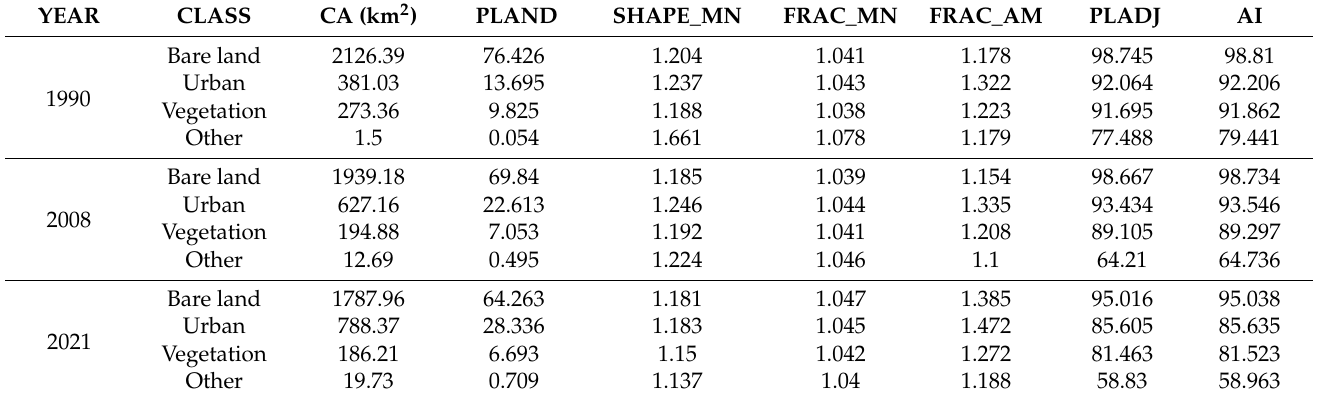
Table 1. Landscape metrics at class level for Lima Metropolitan